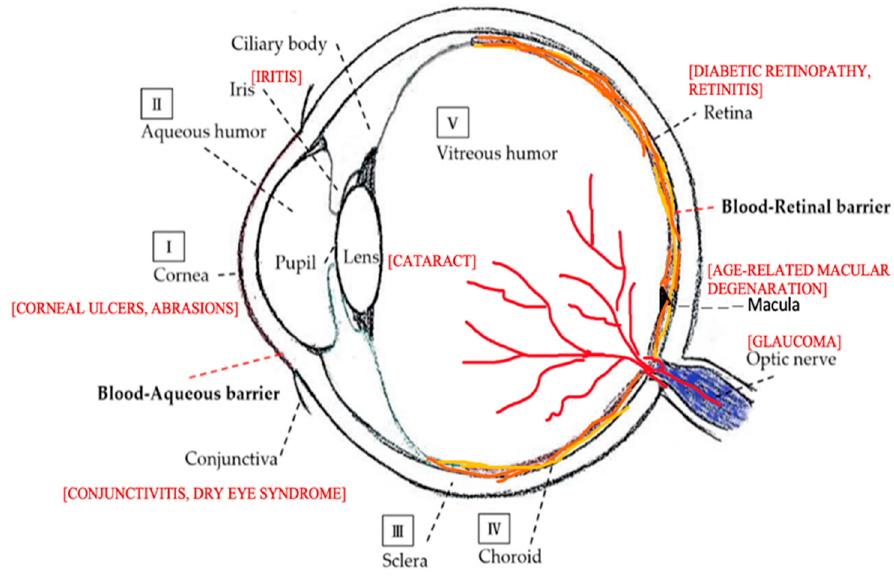
Figure 4. Diseases associated with anterior and posterior segment of eye.